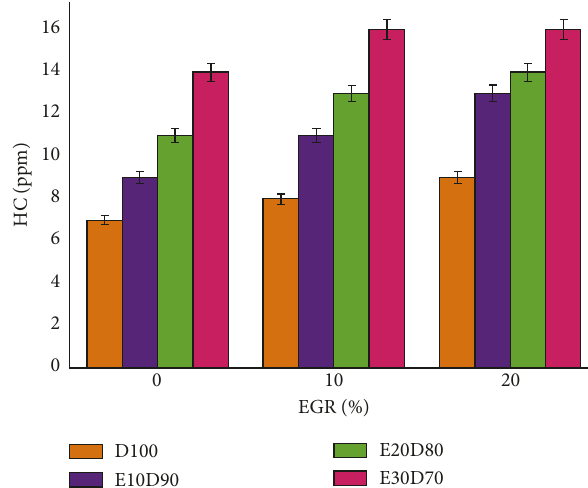
Figure 10: Variation in HC with EGR (0%, 10%, and 20%) at 60% load.